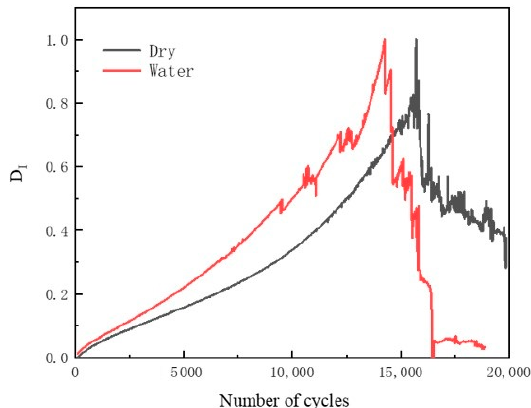
11 of 21 Figure 8. Variation curve of horizontal strain with loading time/times of repeated load. 3.1.4. Analysis of Influence of Moisture on Cracking Resistance of the CR Mixture The cracking of the asphalt mixture was mainly characterized by low-temperature fracture and medium-temperature fatigue cracking. Based on DIC technology, the strain energy density ( D E ) and interfacial damage factor ( D I ) of the CR mixture before and after immersion with different failure forms were analyzed, as shown in Figures 9–12.